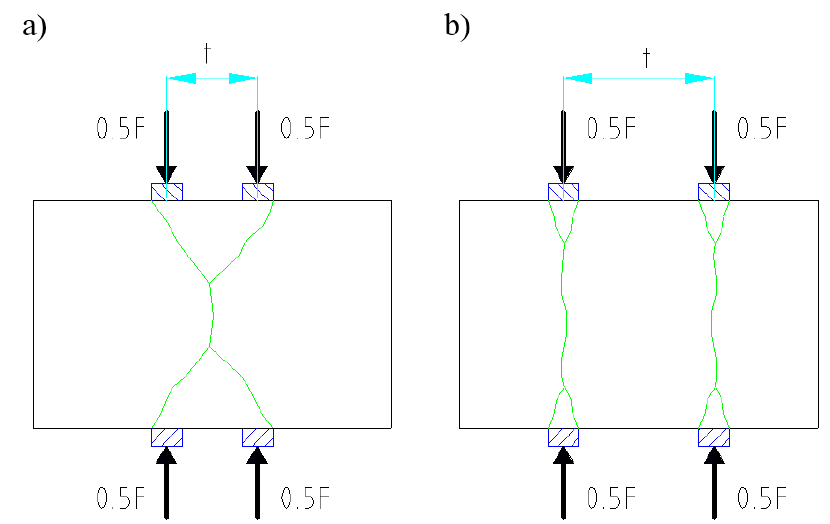
Figure 7: Failure mechanism for coaxially arranged stamps for various pitch length